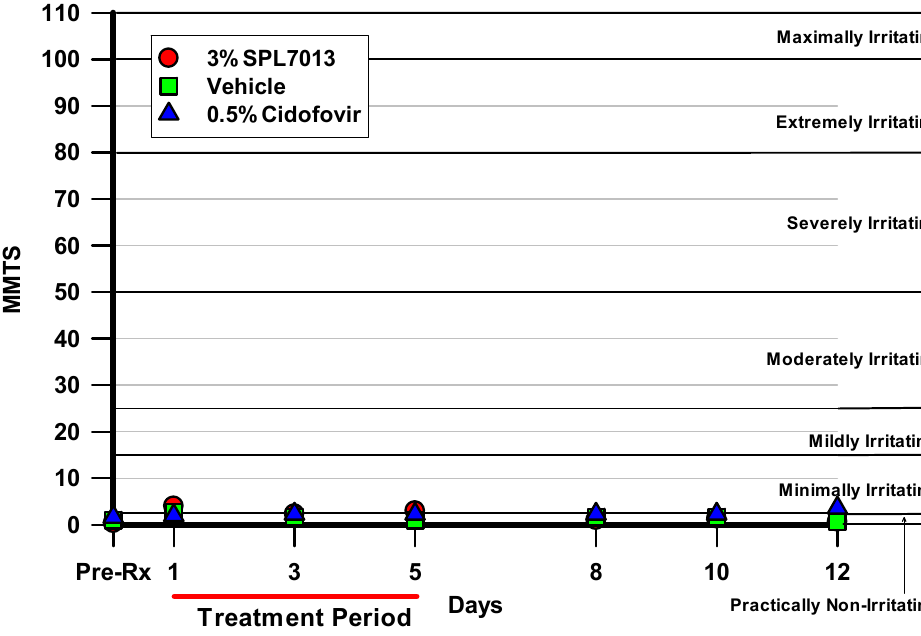
Figure 1. The MMTS values from each treatment group and observation day. 3% SPL7013 demon- strated scores in the minimally irritating to practically non-irritating categories. There were no significant differences among the treatment groups for any day other than day 12 where 3% SPL7013 (median score 0.0) and vehicle (median score 0.0) had significantly lower scores than 0.5% cidofovir (median score 4.0) ( p ≤ 0.0278, K-W). The red line indicates the treatment period (Days 1–5).